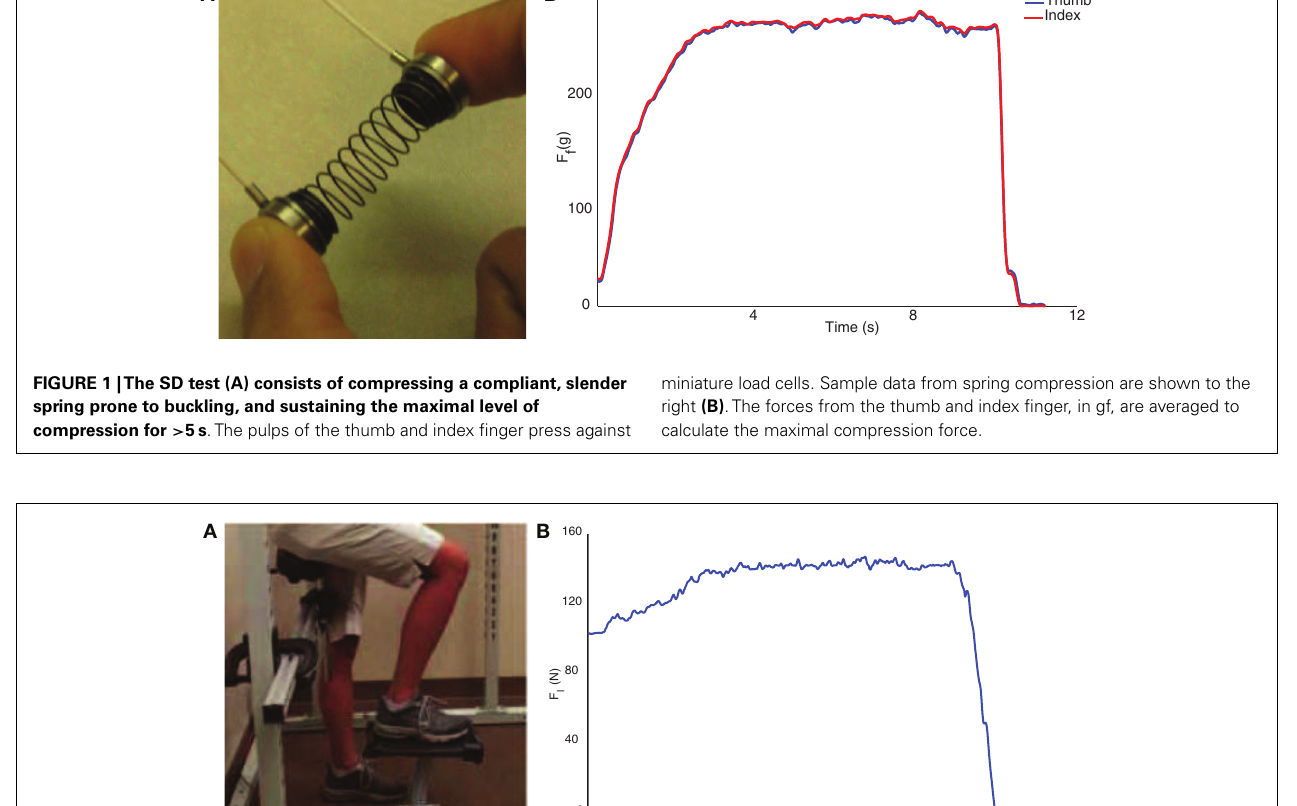
FIGURE 2 |The LED test (A) consists of pressing an appropriately scaled-up spring with the foot against the ground . Compression forces, in N, are quantified with a load cell located under the spring. Sample data from spring compression are shown to the right (B)